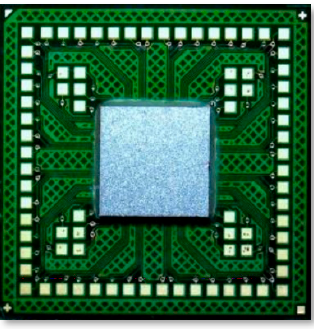
Figure 5. Optical micrograph of thermo-compression (TC)-bonded test sample.